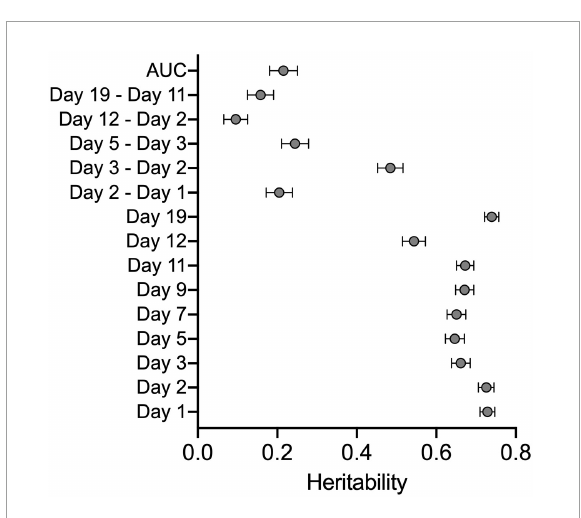
FIGURE3 Broad sense heritability estimates for all derived variables and locomotor activity across all days of testing. Error bars are